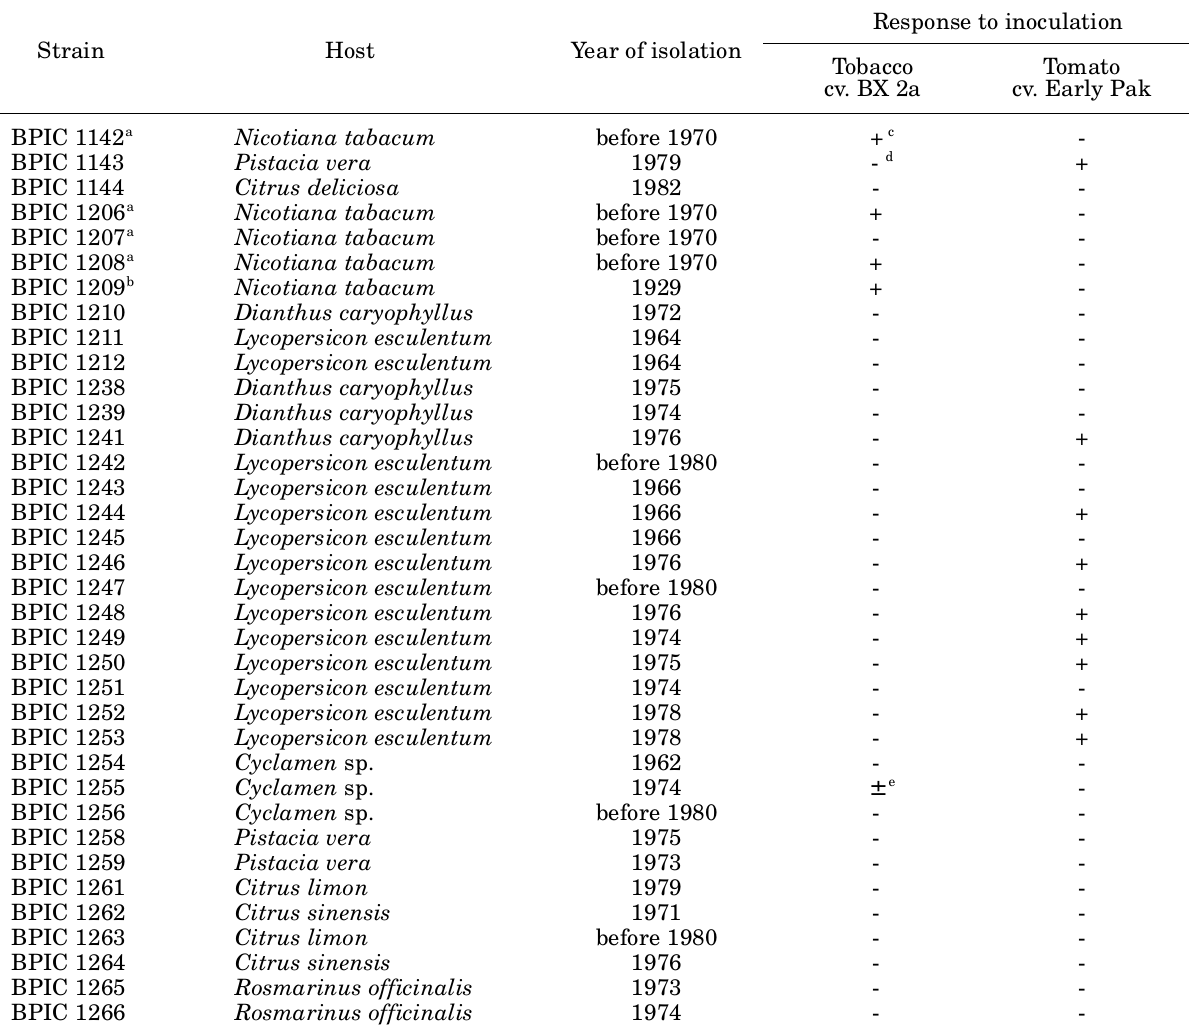
Table 1. Response of tobacco and tomato to inoculation with Phytophthora nicotianae isolates collected from 1929 to